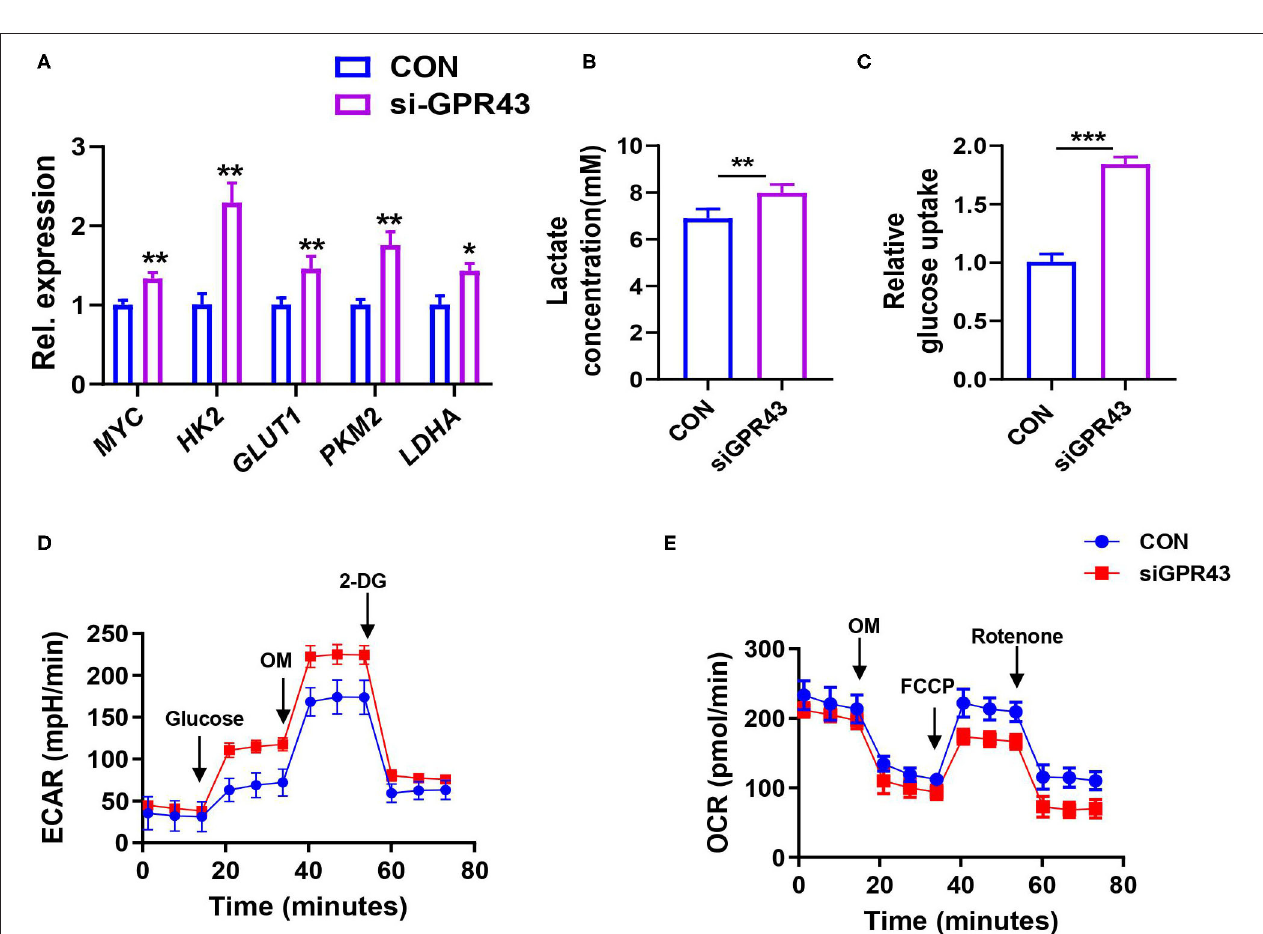
FIGURE 7 | Activating GPR43 can inhibit aerobic glycolysis in the CRC cells. The HCT116 cells were treated with siGPR43 duplexes for 48h. (A) The mRNA expressions of MYC , GLUT1 , HK2 , PKM2 , and LDHA in the HCT116 cells were detected by qPCR. (B) Lactate production of HCT116 cells was detected by Lactate Colorimetric Assay Kits. (C) Glucose uptake of HCT116 cells was detected by Glucose Uptake Fluorometric Assay Kits. (D) The ECAR of HCT116 cells was measured by the Seahorse XF Glycolysis Stress Test Kit. (E) The OCR of HCT116 cells was measured by the Cell Mito Stress Test Kit. Data with error bars are presented as mean ± SD. Each panel is a representative experiment of at least three independent biological replicates. * P < 0.05, ** P < 0.01, and *** p < 0.001 as determined by unpaired Student’s t